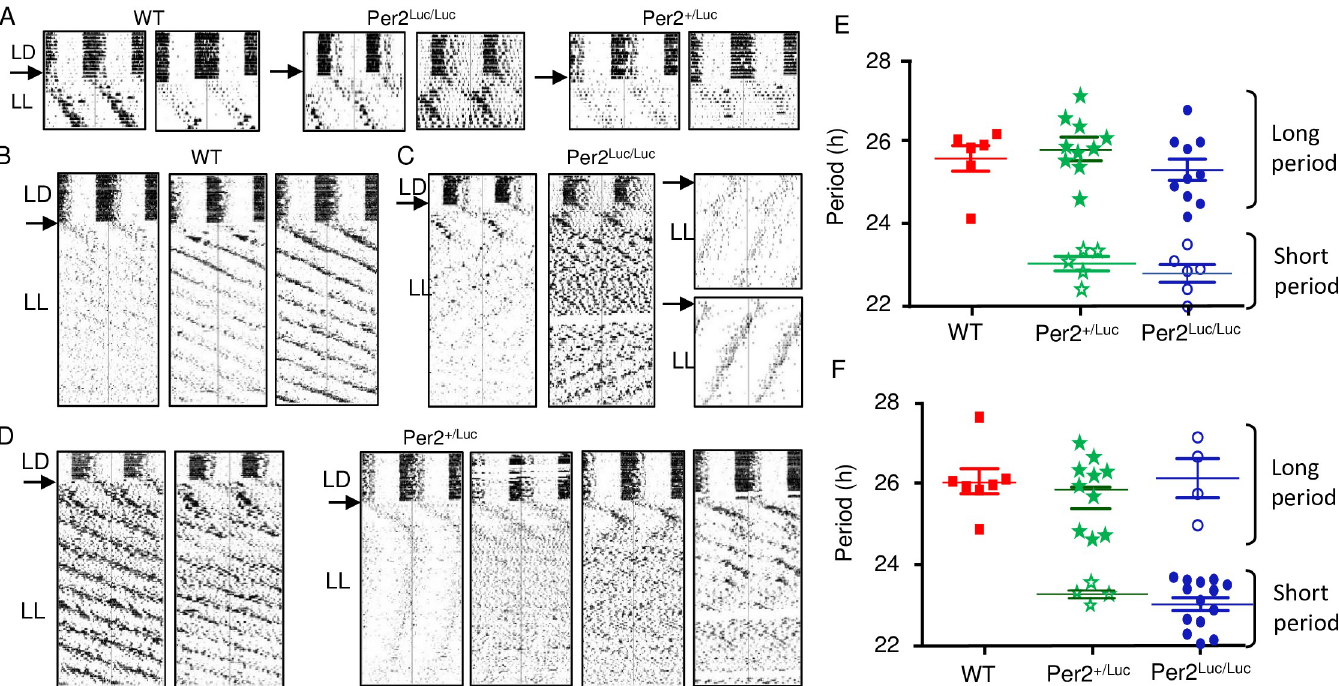
Fig 4. Period dissociation in LL detected by long tern recording of RWA. A . Initial responses of RWA to transition from LD12:12 cycle to LL. Two representative actograms from each genotype are shown. B, C, D. Examples of long term RWA in WT, mPer2 Luc/Luc , and Per2 +/Luc mice, respectively. All animals were entrained to LD12:12 prior release into LL. Wild type animals (B) show the expected range of periods (all > 24 h in LL); whereas homozygous mPer2 Luc/Luc mice (C ) show dual rhythms ( < 24 h and > 24 h in LL). ( D ) Heterozygous mPer2 +/Luc mice exhibit individual variance with patterns ranging between the wild type and mutant characteristics, as well as unpredictable arrhythmicity over time in LL. E . Period analysis of rhythm from the 3 genotypes in the first 7 days following transition from LD to LL. Red, Green, Blue symbols indicate significant periods of individual mice from each of the three genotypes. Closed symbols indicate the higher amplitude rhythm. Open symbols indicate a second significant rhythm with lower amplitude. No significant genotype differences were found among either long periods or short periods. F . Expression of short ( < 24 h) and long ( > 24 h) periods in LL determined 12 weeks following entry into LL (symbols shown as described in 4F). No significant differences between genotypes as in 4E. Long and short periods were significantly different within genotype for both mPer2 Luc/Luc and Per2 +/Luc .